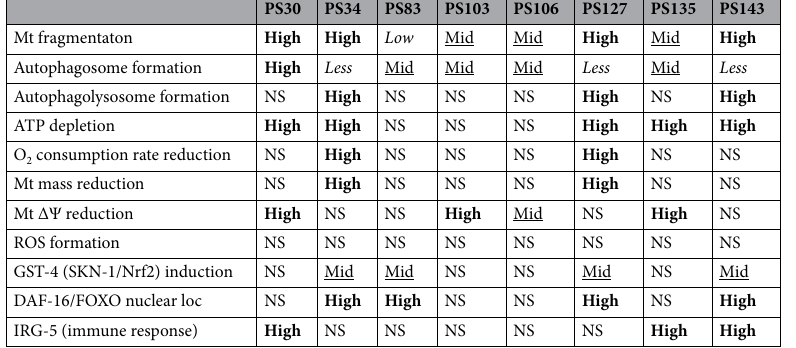
PS30 PS34 PS83 PS103 PS106 PS127 PS135